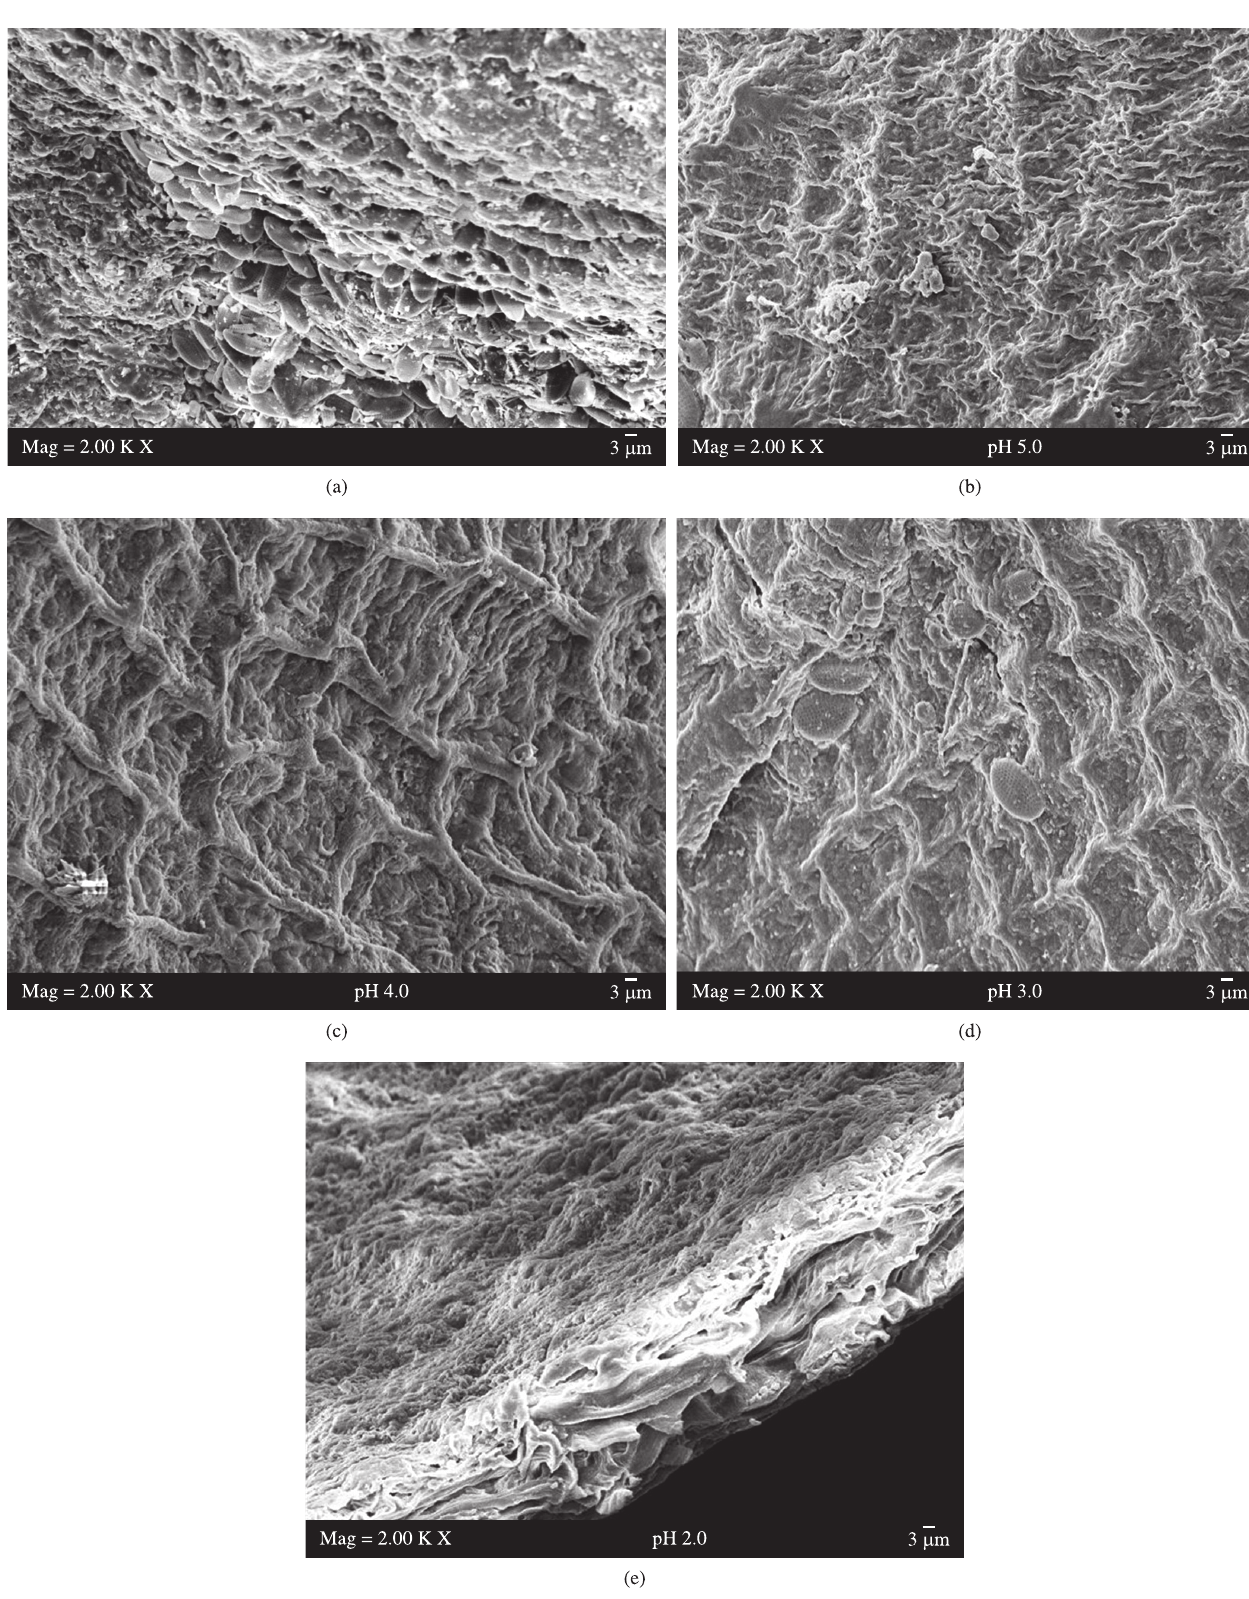
Figure 4. Scanning electron microscopy (SEM) micrographs (2000× magnification) of a) raw Sargassum filipendula ; b) acid treatment Sargassum filipendula pH 5.0; c) acid treatment Sargassum filipendula pH 4.0; d) acid treatment Sargassum filipendula pH 3.0; and e) acid treatment Sargassum filipendula pH